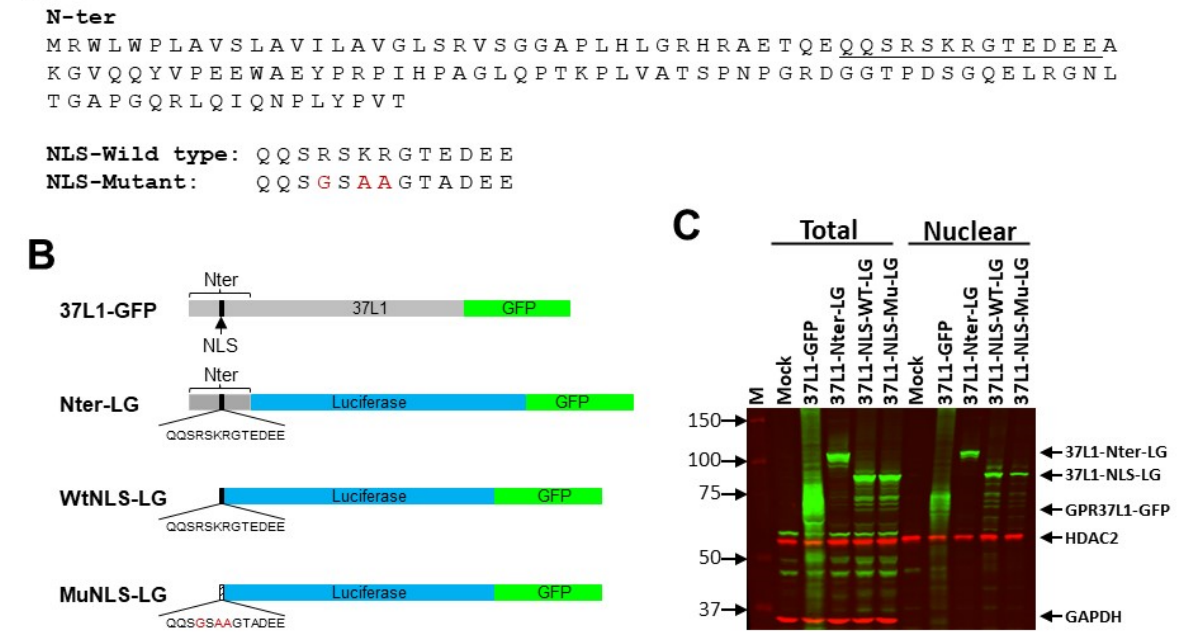
Figure 4. NLS for GPR37L1 is located on the amino terminus . ( A ) N-terminus (N-ter) 124-amino- acid sequence of GPR37L1 showing the potential monopartite (underlined) NLS sequence, NLS wild-type, and NLS mutant sequences fused to luciferase–GFP fusion (LG) constructs. ( B ) Diagram showing the plasmid constructs of wild-type or the N-terminus mutants of GPR37L1 tagged to LG fusion cDNA (LG) (37L1-Nter-LG) or the wild-type or mutant NLS tagged to LG (37L1-WtNLS-LG or 37L1-MuNLS-LG). ( C ) hRPTCs were transfected with the indicated plasmids. The wild-type or mutant GPR37L1 expressions were determined by immunoblotting of the total or nuclear protein preparations, using two-color infrared fluorescent protein detection. Expression of the LG constructs was detected using the GFP antibodies (green). The blot was probed sequentially for HDAC2 (red), a marker for nuclear protein, or GAPDH (red), a marker for cytoplasmic proteins. IRDye ® 800CW-labeled donkey anti-rabbit IgG (926-32213, Licor, Lincoln, NE, USA) was used for GPR37L1-GFP, and IRDye ® 680RD-labeled donkey anti-mouse IgG (926-68022, Licor, Lincoln, NE, USA) was used for HDAC2 and GAPDH. hRPTCs transfected with pcDNA, an empty vector, served as control. Positions of the molecular size markers are indicated on the left, and the GPR37L1-GFP, 37L1-NLS-LG, HDAC2, and GAPDH proteins are indicated on the right.